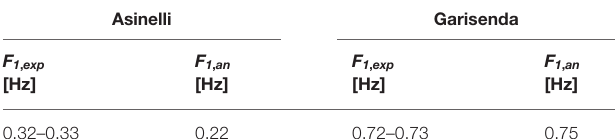
TABLE 3 | Experimental vs. analytical values of the fundamental frequency for the Asinelli and Garisenda Towers. Asinelli